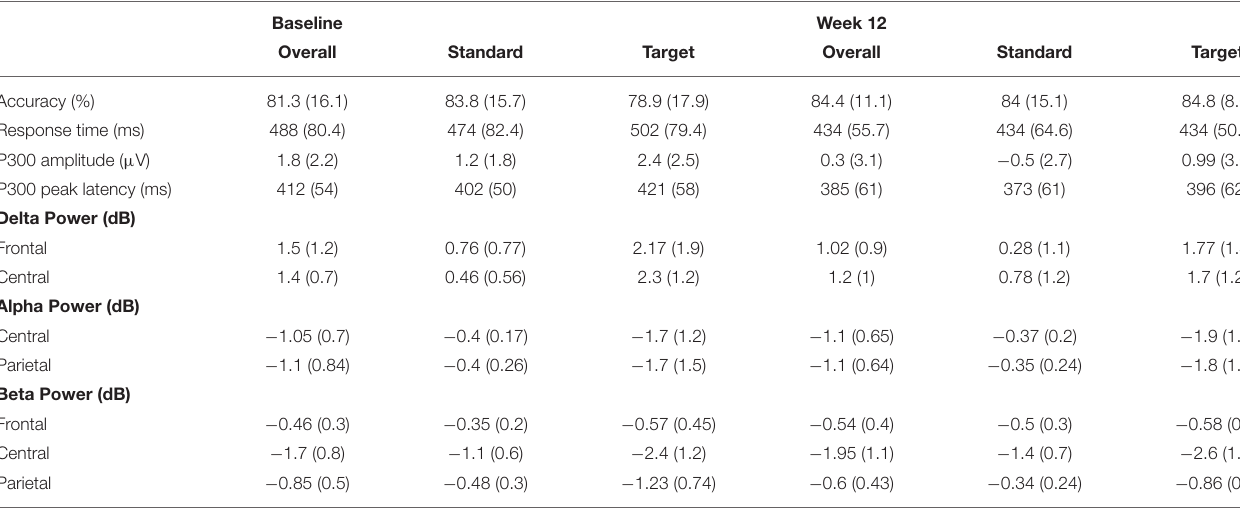
TABLE 2 | Auditory oddball